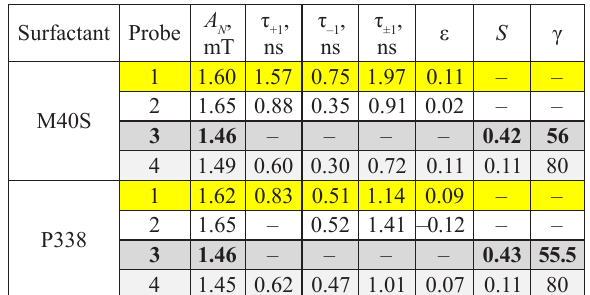
Parameters of EPR spectra of spin probes in solutions of Surfactant Probe